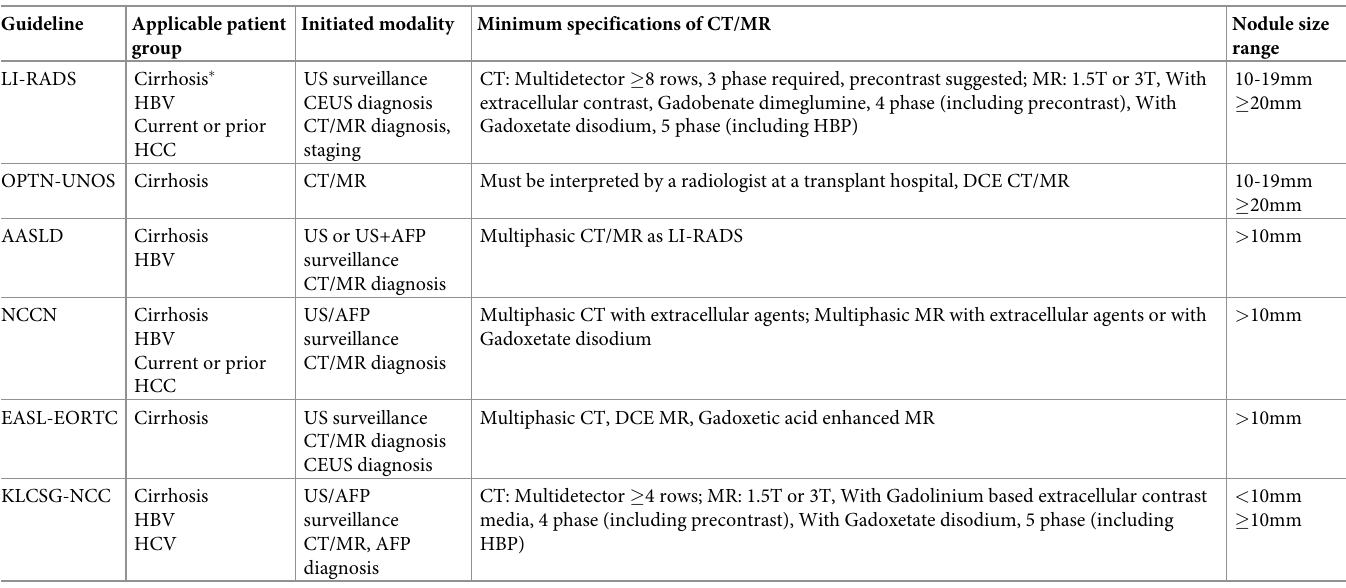
Table 1. Major difference between